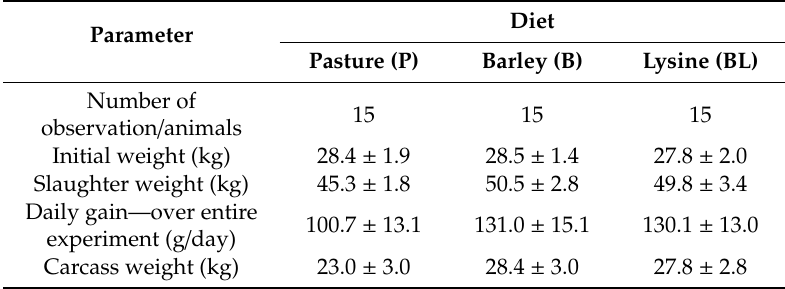
Table 1. Means ± standard deviations of the growth performance and carcass traits of fallow deer bucks receiving di ff erent diets (pasture only, barley + pasture, barley + lysine + pasture). For further details regarding supplementation rates and diet composition, see